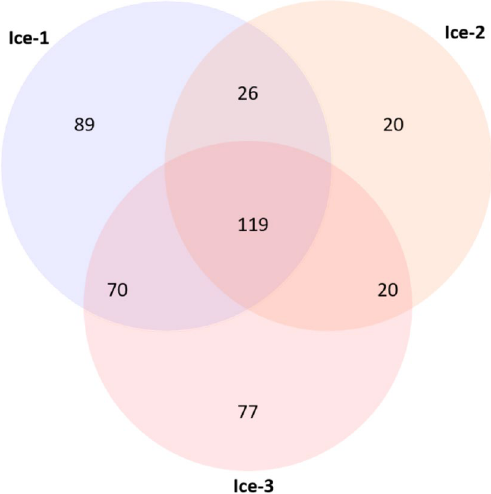
Figure 1. Prokaryotic OTU distribution in cave ice. The Venn diagram indicates the number of distinct and shared OTUs in ice samples Ice-1, Ice-2 and